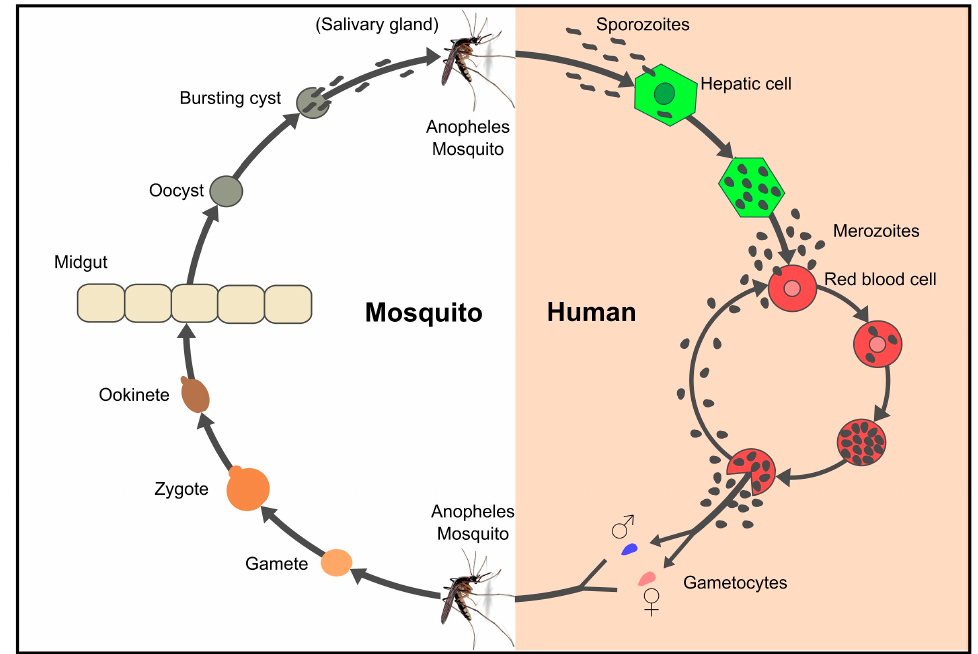
Figure 2. Life cycle of Plasmodium falciparum. Spz entry through the bite of a female Anopheles mosquito begins the Plasmodium spp. life-cycle in humans. Spz travel through the bloodstream to reach and invade liver cells, thereby initiating the pre-erythrocyte cycle [70]. Spz grow and divide within the hepatocytes, producing 10,000–30,000 Mz per invaded hepatocyte, depending on the Plasmodium specie [71]. Once Mz are released into the bloodstream, each one can invade RBCs in about 45 s. Mz develop to ring, trophozoite and (48 to 72 h) schizont stages inside RBC, producing about 8–32